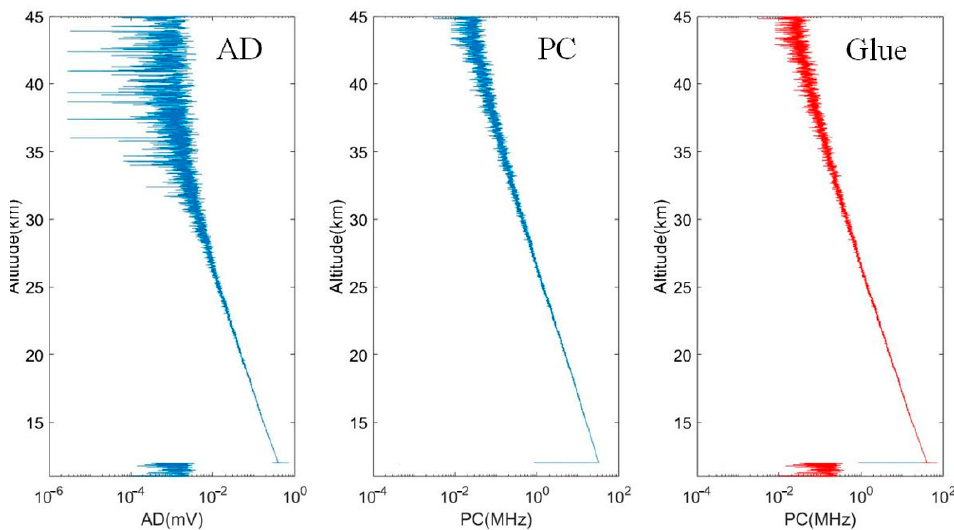
Figure 5. The results of gluing for the AD and PC signal. Table 3. Control and acquisition parameters.